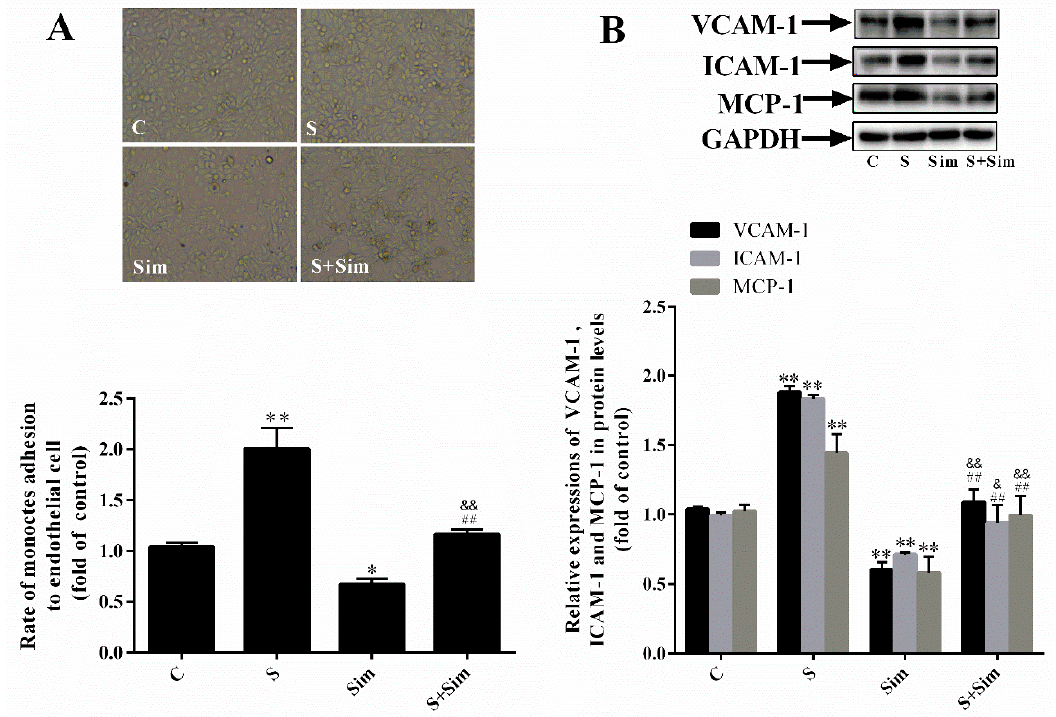
Figure 6. Overexpressed SMS2 increases the adhesion activity of HUVECs and THP-1 cells by increasing the deposition of intracellular cholesterol. ( A ) The adhesion ratio of THP-1 cells to HUVECs (magnification 40×). ( B ) Western blot analysis detected the protein level of VCAM-1, ICAM-1, and MCP-1. n = 3, * p < 0.05 and ** p < 0.001 vs. the C group; ## p < 0.001 vs. the S group. && p < 0.001 vs. the Sim group. C, cells treated with empty plasmids treated with H 2 O 2 (450 µmol/L) for 24 h; S, cells overexpressing SMS2 treated with H 2 O 2 (450 µmol/L) for 24 h; Sim, empty plasmids treated with simvastatin (0.1 µmol/L) for 24 h and then treated with H 2 O 2 (450 µmol/L) for 24 h; S+Sim, cells overexpressing SMS2 treated with simvastatin (0.1 µmol/L) for 24 h and then treated with H 2 O 2 (450 µmol/L) for 24 h.